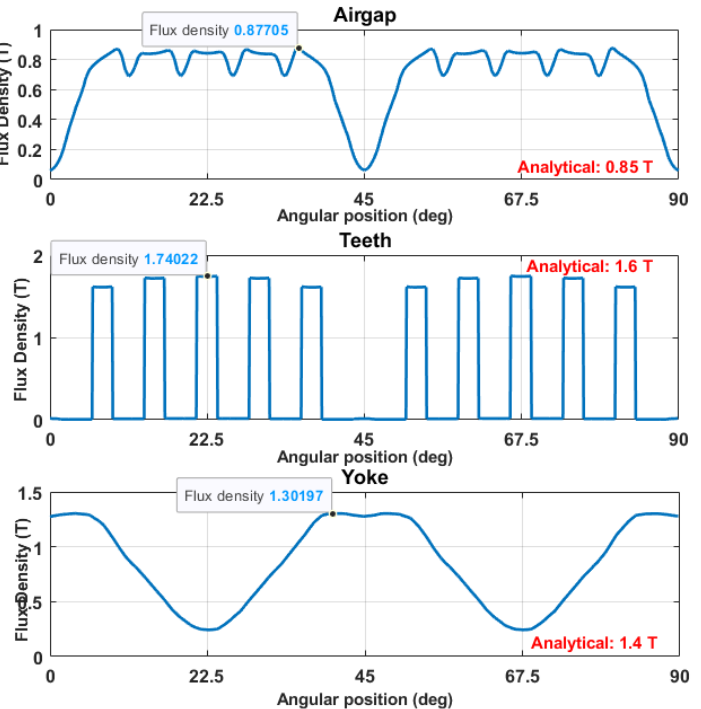
Figure 6. Comparison in terms of flux density in the airgap, teeth, and yoke.